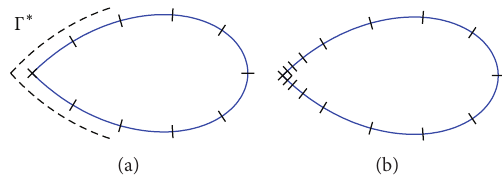
Figure 2: (a) A coarse mesh with ten panels on the contour Γ of (1) with opening angle 𝜃 = 𝜋/2 . A subset of Γ , called Γ ⋆ , covers four coarse panels as indicated by the dashed curve. (b) A fine mesh created from the coarse mesh by subdividing the panels closest to = 3 the corner 𝑛 sub